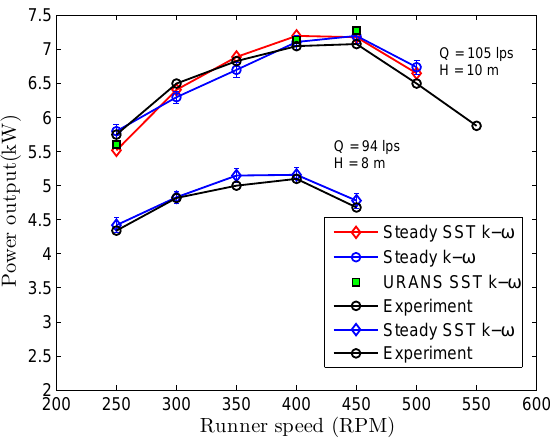
Figure 2. Comparison of CFD and experimental results for the power output of the 7 kW turbine at different flow rates and heads. different flow rates and